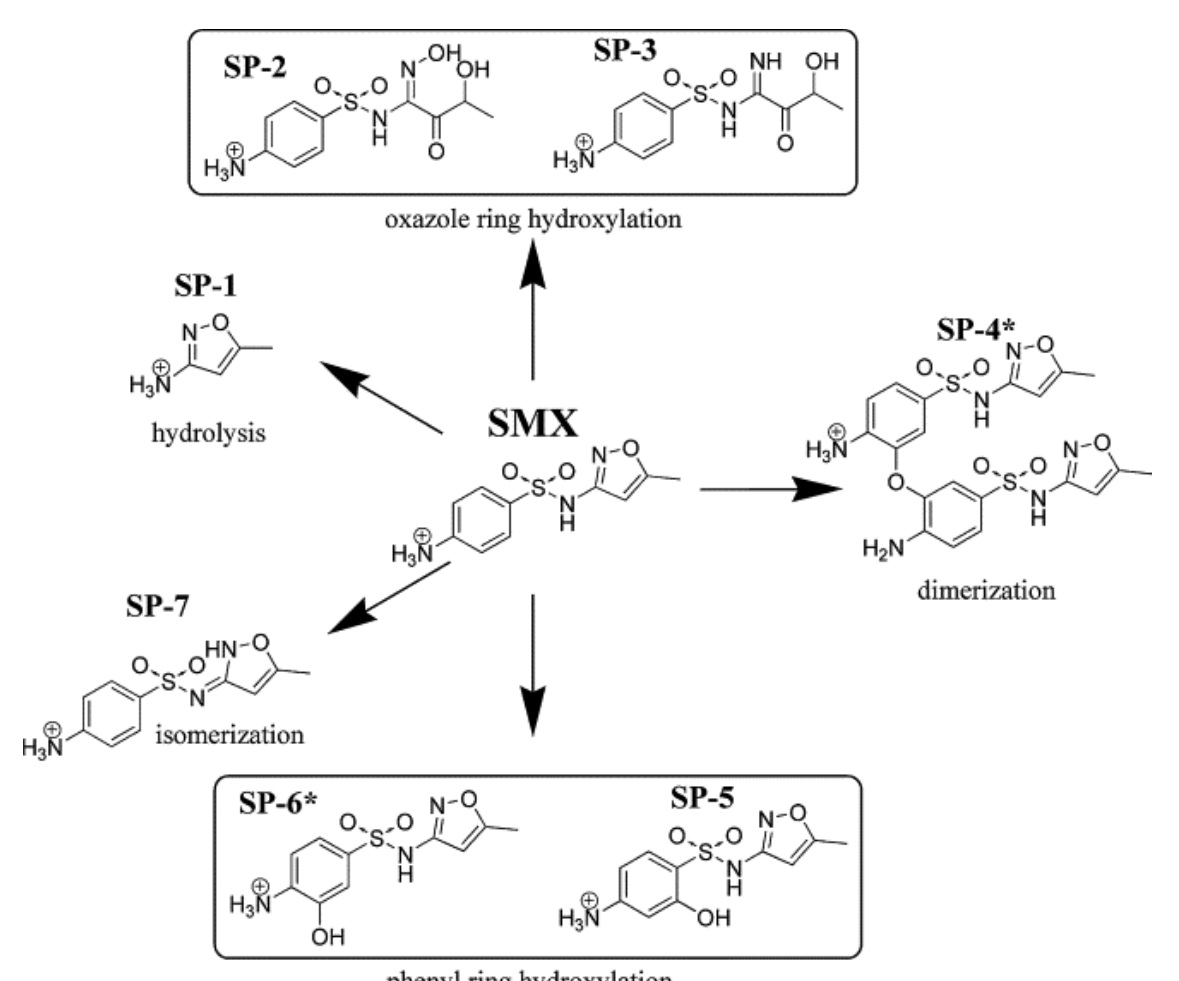
Figure 13. A proposed mechanism for the degradation of sulfamethoxazole antibiotic using (EP-TiO2-773). The degradation was determined by HPLC analysis, which showed the disappearance of sulfamethoxazole peaks and the appearance of new peaks. Two pathways are mainly involved. The first pathway involves the photogeneration of hydroxyl radicals which resulted from the interaction of holes with water. The second pathway involves the electron transfer from the excited organic molecule to TiO 2 conduction band. Adapted with permission from [121]. Copyright 2015 Elsevier.